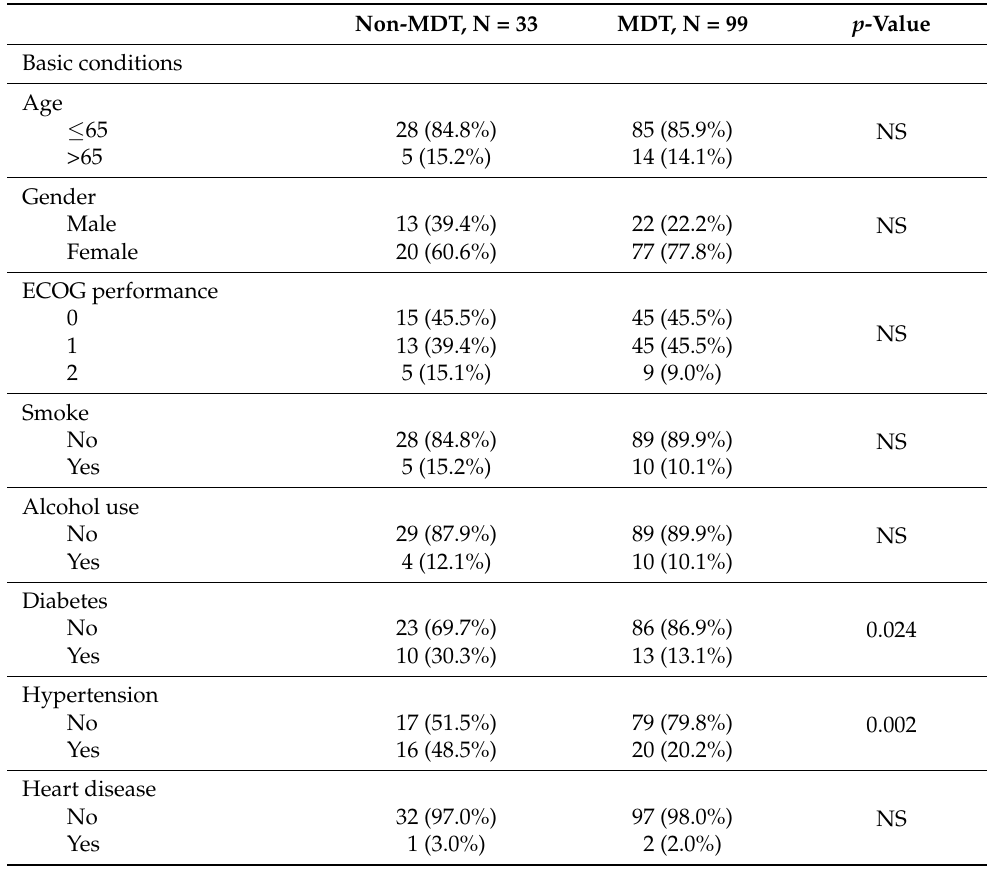
Table 1. Demographic and clinical characteristics of the patients who underwent